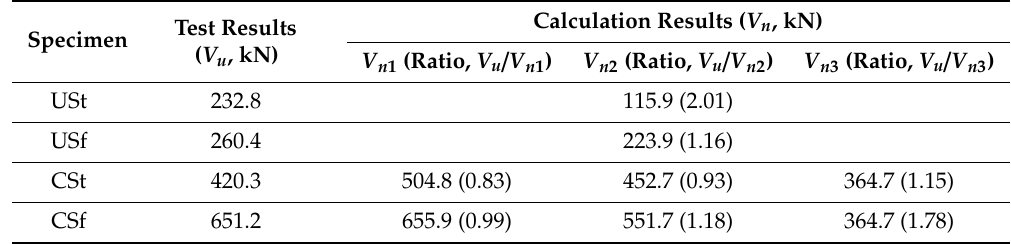
Figure 11. Comparison of the test and analysis results on the shear specimens; ( a ) Non-composite members; ( b ) Composite members. Table 4. Comparison of shear strengths.